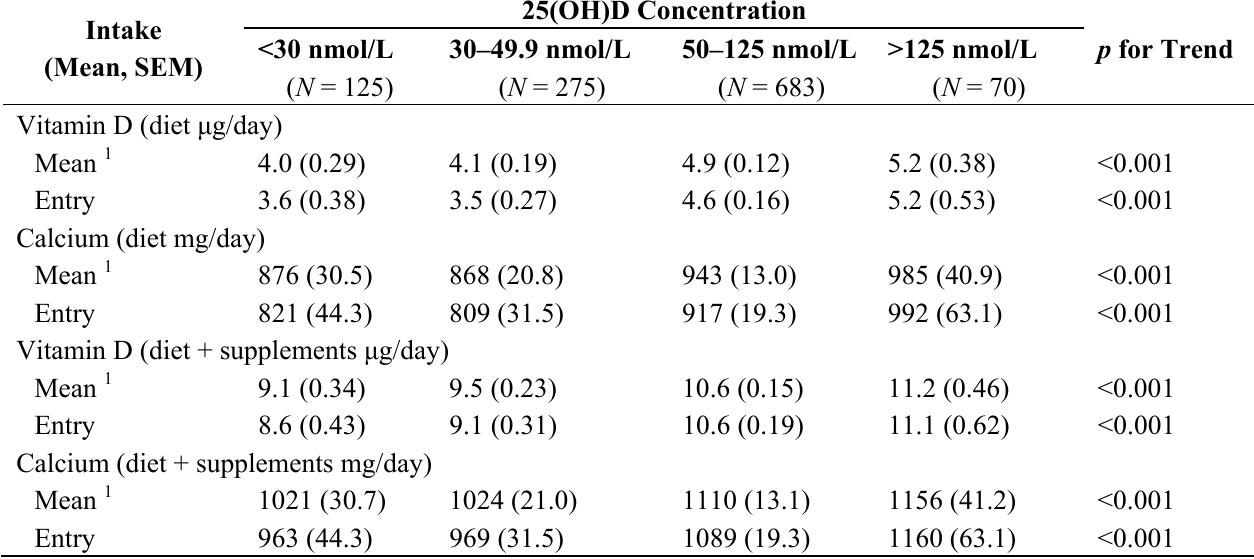
Table 2. Energy adjusted intake of vitamin D and calcium from diet and diet plus supplements by 25(OH)D